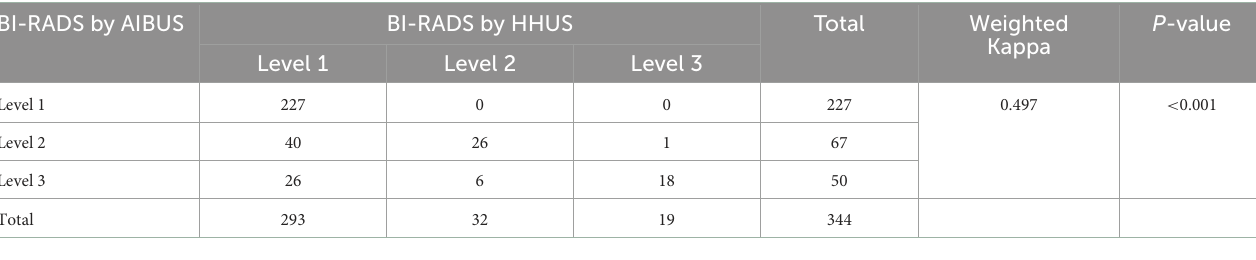
TABLE 4 Comparison between AIBUS read by junior radiologists and HHUS in BI-RADS categorization. BI-RADS by